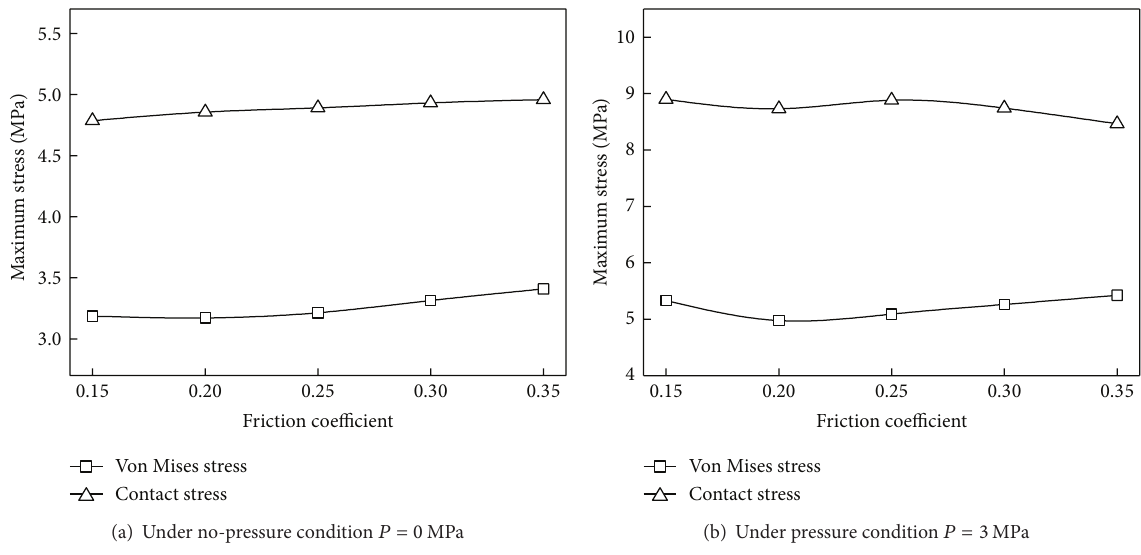
Figure 10: Stress of the biomimetic sealing ring under different friction coefficients.